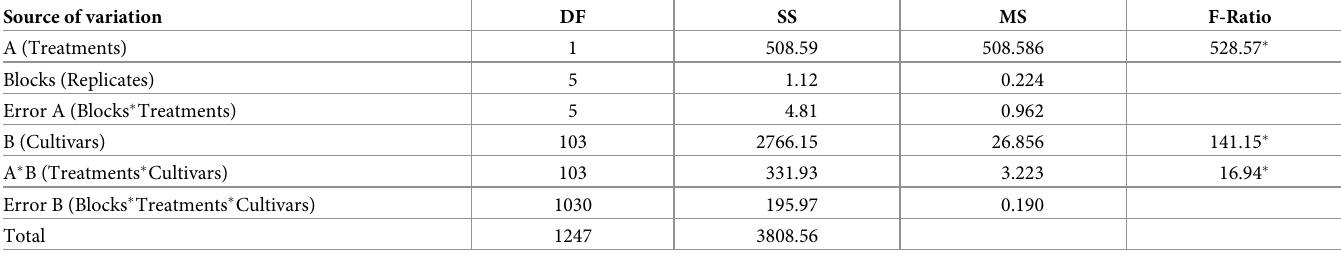
Table 4. Analysis of variance of cultivars and disease treatments for pol contents. Source of